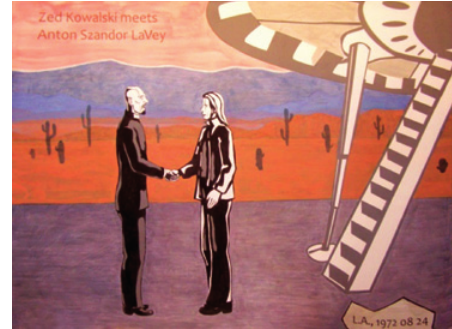
Fig. 2. Konstantinas Gaitanži. Zed Kowalski meets Anton Szandor LaVey